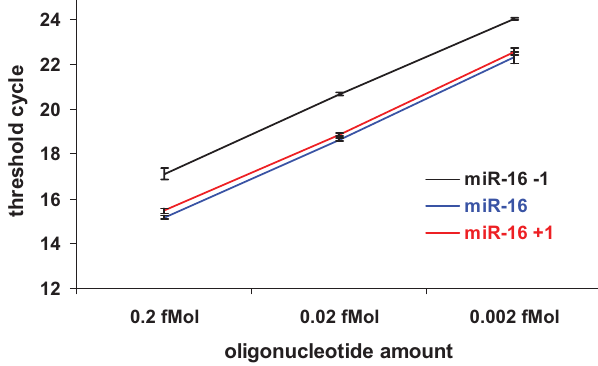
Figure 6. miRNA 3 9 end heterogeneity affects detection efficiency of stem-loop primer-based real time PCR. Detection efficiency was compared using exact miR-16 oligonucleotide and miR-16 oligonucle- otide with 1 nt deletion or 1 nt addition at the 3 9 end as templates. Mean of triplicate experiments 6 SD is shown.